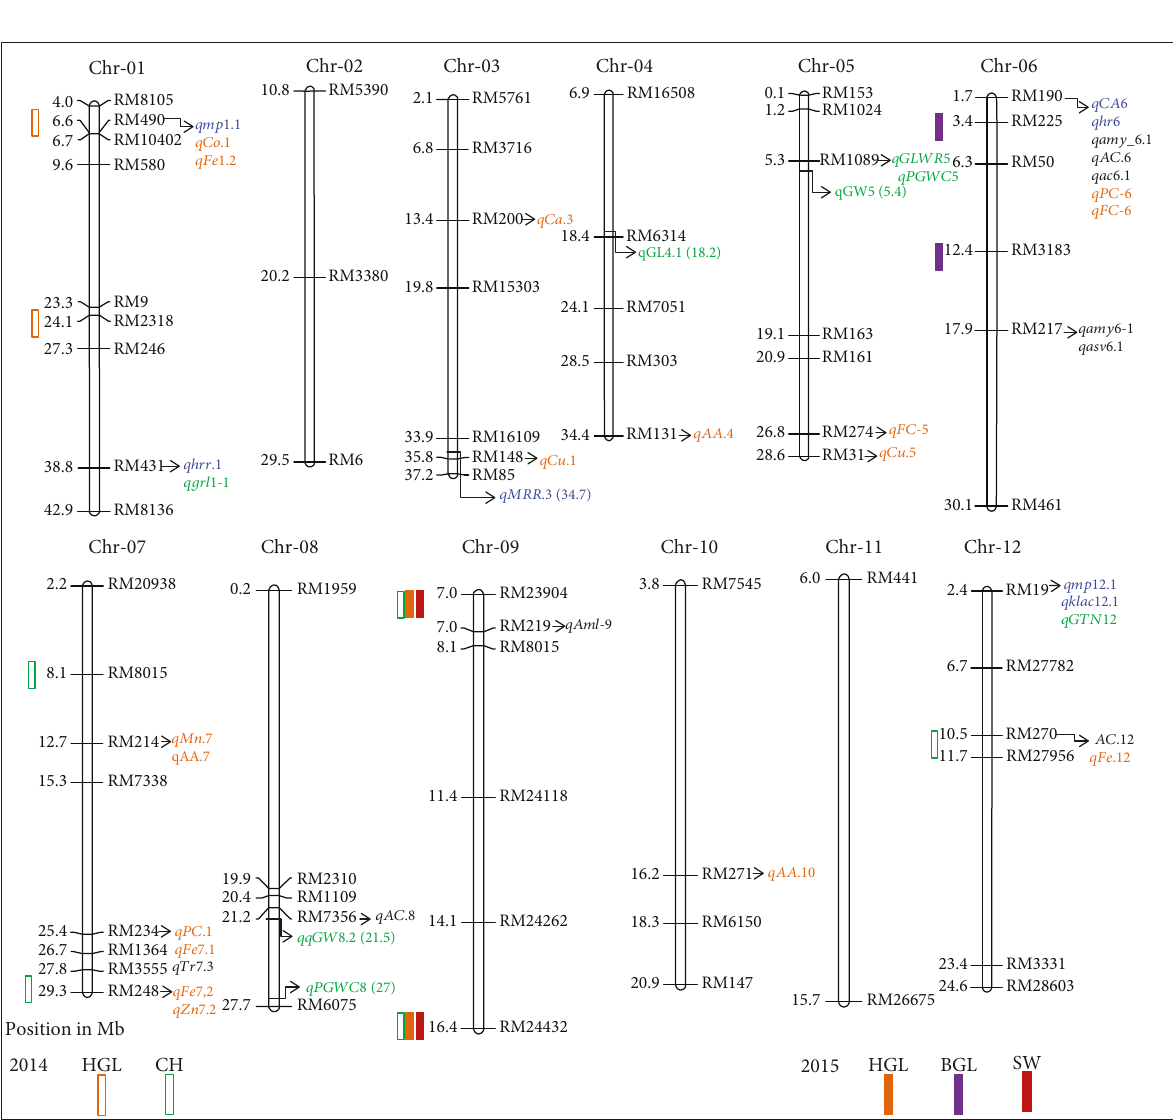
Figure 3: Distribution of QTLs for grain appearance and validation with previous reports on the linkage map. The hollow and solid bars indicate the QTLs detected in 2014 and 2015, respectively. The left and right sides indicate the polymorphic SSR marker physical positions (Mb) associated with previous reports. A color font of each QTL represents the classi fi cation of grain appearance and nutritional quality traits. Blue color fonts are related to milling properties of grain quality (MPGQ) QTLs, green color fonts for grain appearance (GA) QTLs, orange color fonts for nutritional factor- (NF-) related QTL (NF), and black color font for cooking property (CP) QTLs in